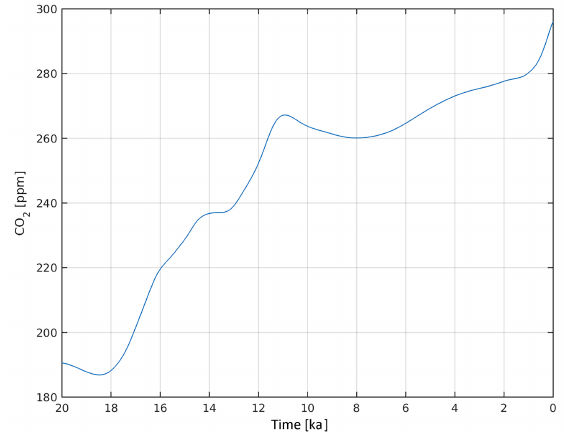
Figure A7. Atmospheric CO 2 equivalent concentration from 20ka to PI prescribed in JSBACH. Data were obtained from a CLIMBER- 2 glacial-cycle simulation (Ganopolski et al., 2010).